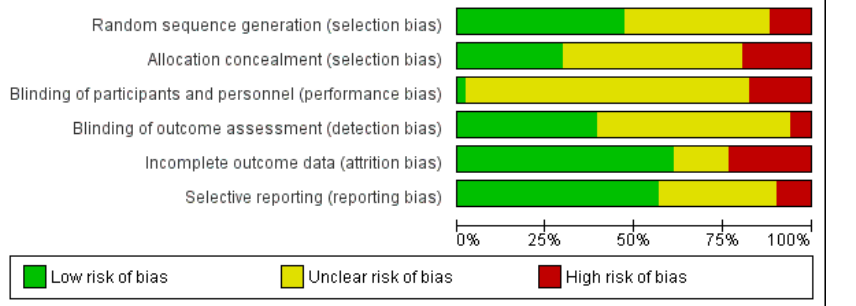
Figure 2. Risk of bias graph: review authors’ judgements about each risk of bias item presented as percentages across all included studies.